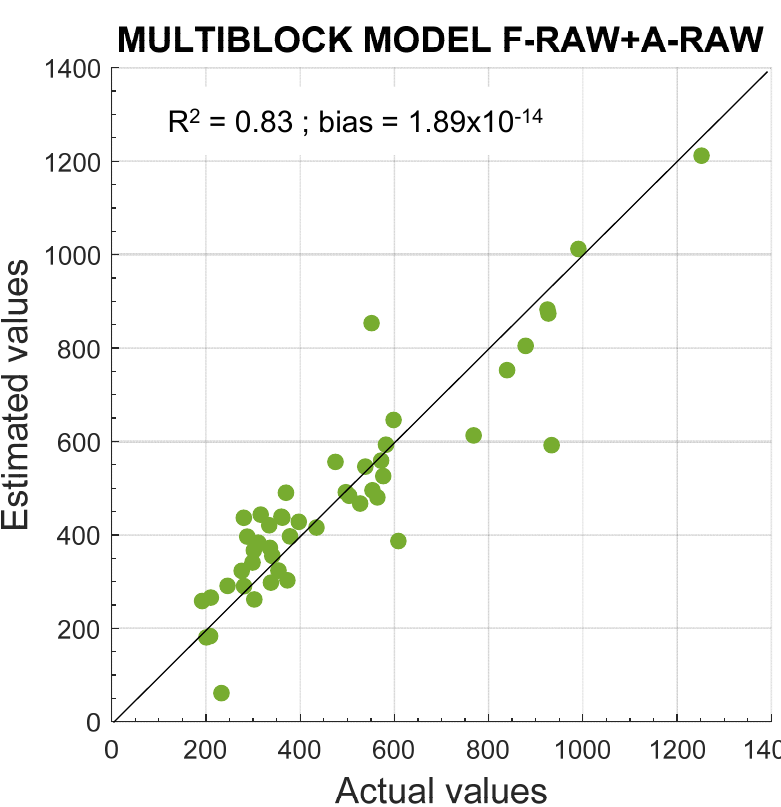
Figure 7. Scatter plot of actual total polyphenol content and estimated content for multiblock model using three LVs for fluorescence raw data and one LV for absorbance raw data.